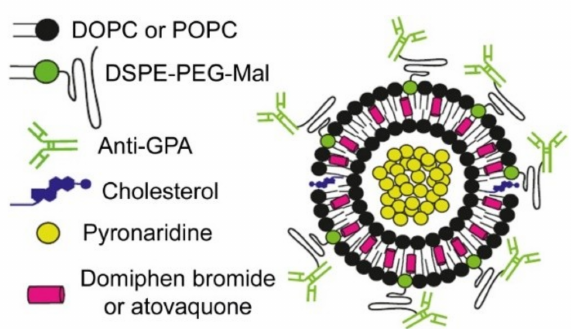
Figure 1. Scheme of the immunoliposome designed here for targeted antimalarial combination